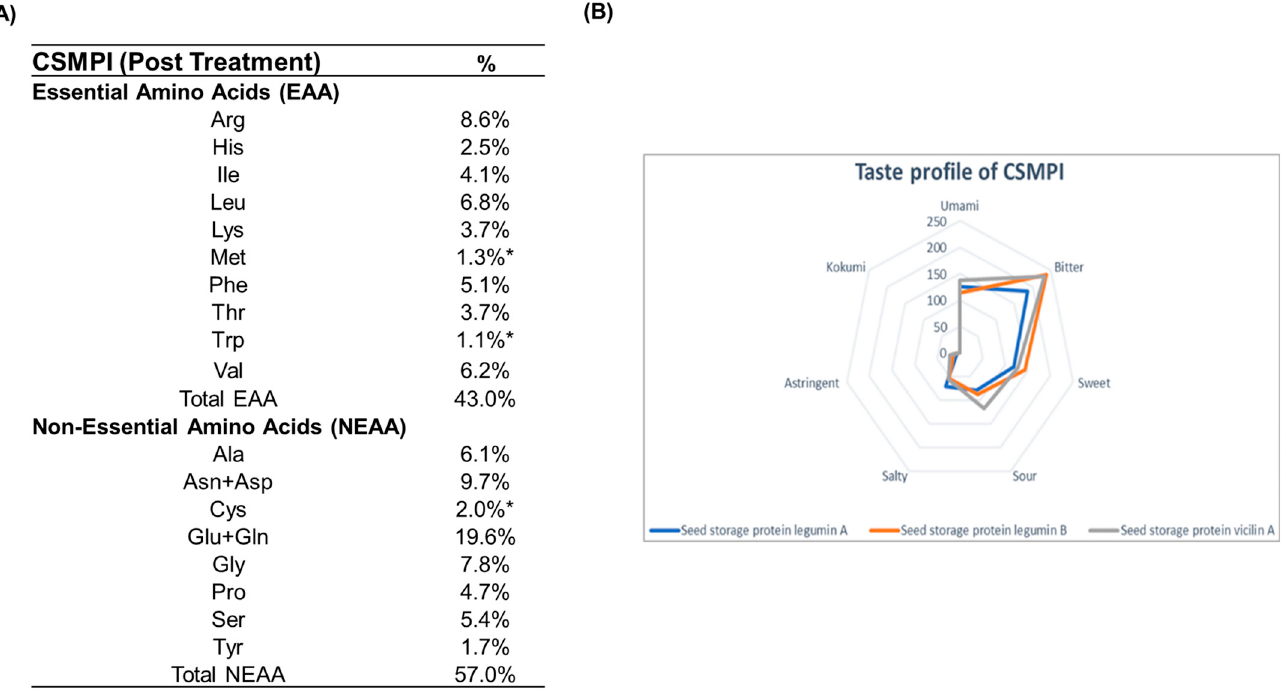
Figure 4. Amino acid analysis of post-treated CSMPI. ( A ) Amino acid composition of post-treated CSMPI. ( B ) Taste profile of the top 3 most abundant proteins of CSMPI. * The percentages of amino acids are calculated using a molar-ratio normalized sequence-based analysis.